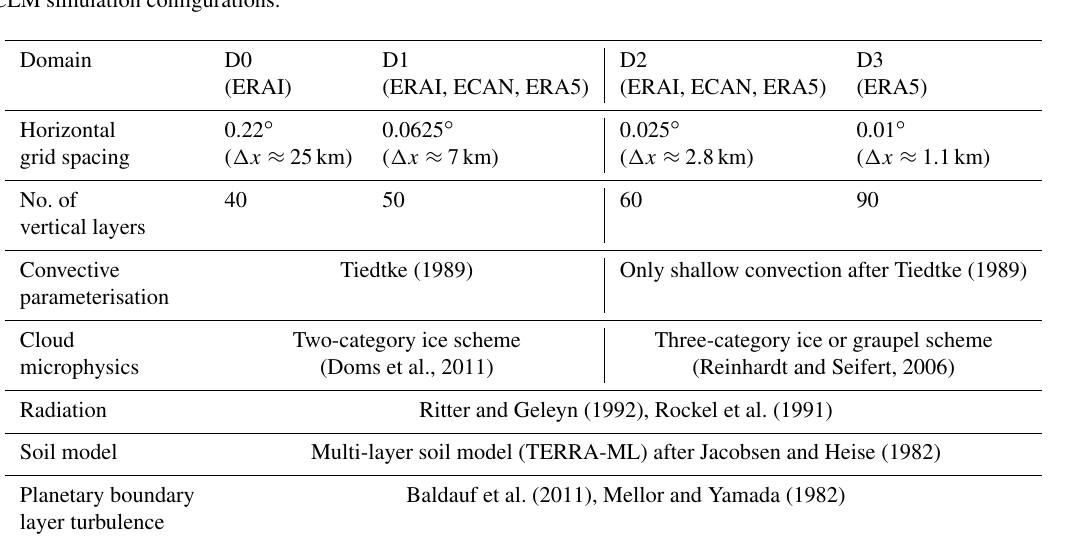
Figure 2. (a) Computational domains used for the nesting of the CCLM simulations and (b) Gantt chart overview of the different CCLM configurations and initialisation times. Table 1. CCLM simulation